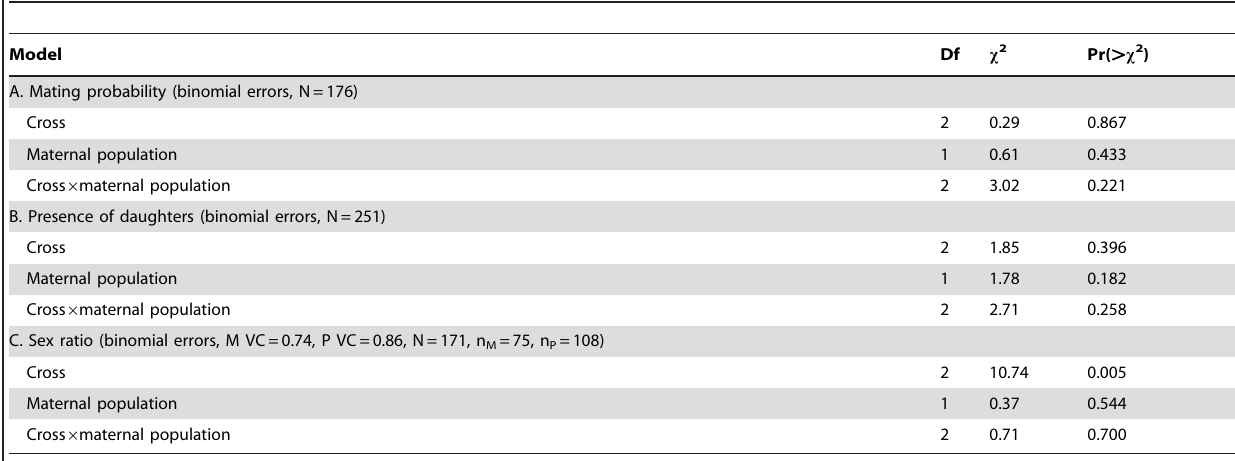
Table 2. Generalized linear models and generalized linear mixed model for (A) mating probability, (B) presence of daughters among progeny, and (C) offspring sex ratio.